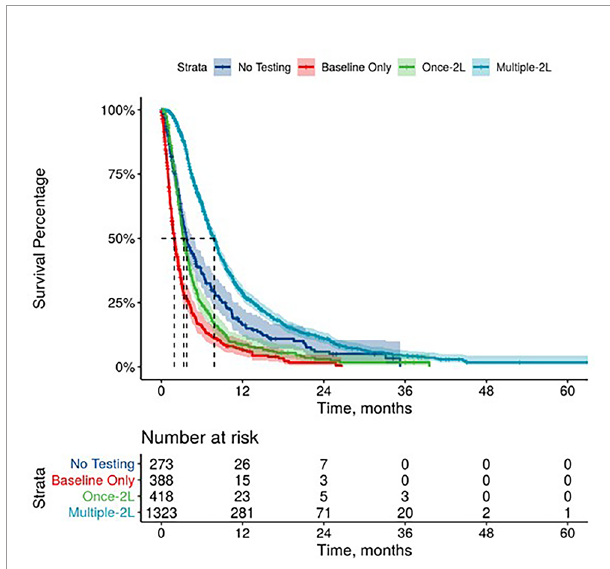
FIGURE 3 | Overall Survival by Carbohydrate Antigen 19-9 Testing Status among patients treated in second